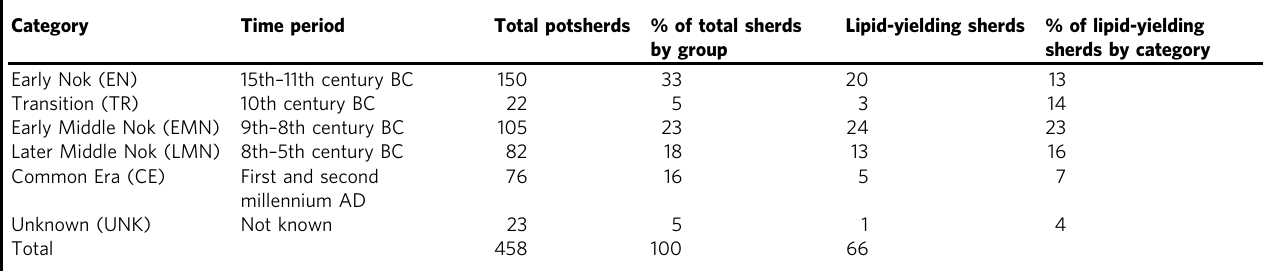
Table 1 Total number of potsherds (from each category and period) sampled for lipid analysis, shown by group, and number of potsherds containing lipids, as percentage of each